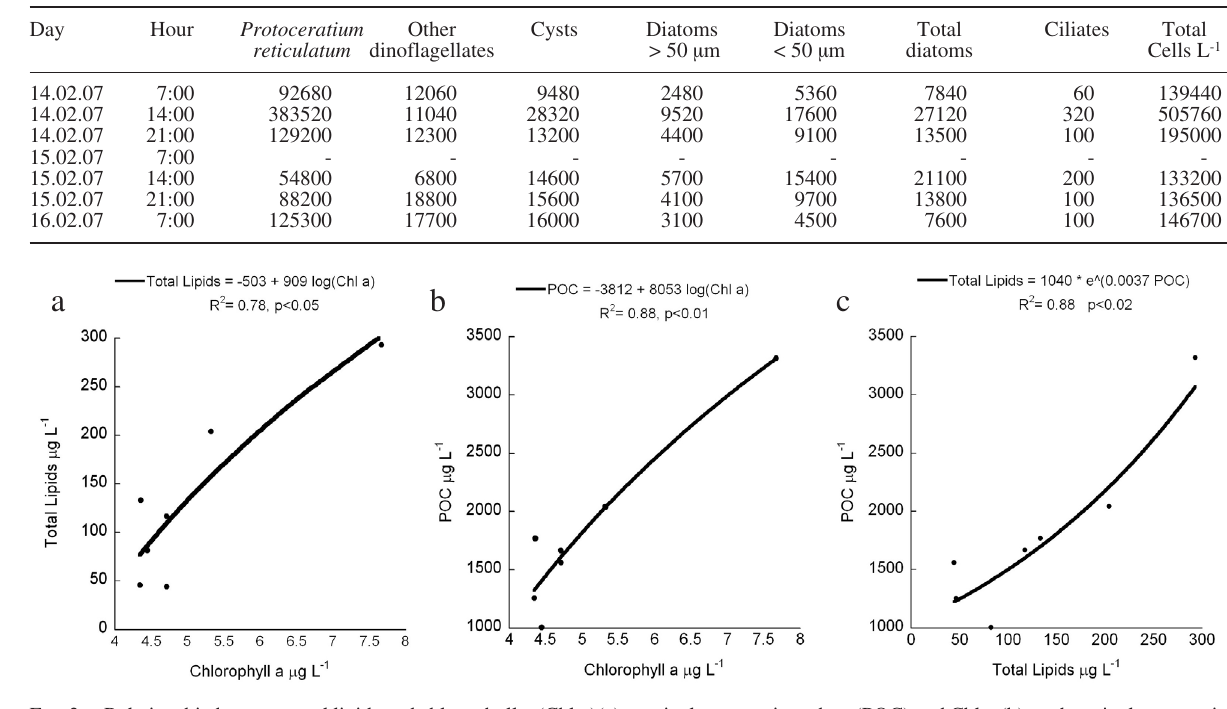
Fig . 3. – Relationship between total lipids and chlorophyll a (Chl a )(a), particulate organic carbon (POC) and Chl a (b), and particulate organic carbon (POC) and total lipids (c) during the 48-hour cycle at Chipana Bay. Equation and significance are shown for each curve